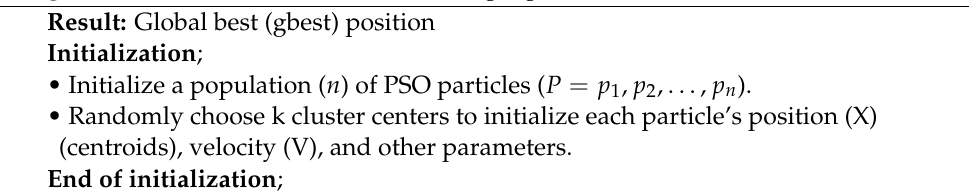
Algorithm 2: PSO text document clustering